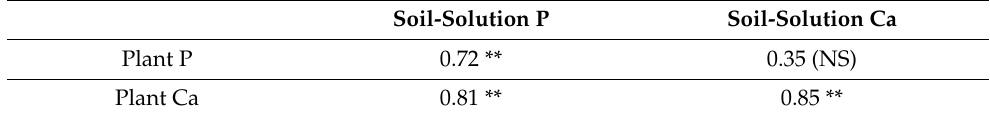
Table 6. Pearson correlation coefficients of plant tissue Ca and P vs. soil-solution Ca and P. Soil-Solution P Soil-Solution Ca Plant P 0.72 ** 0.35 (NS) Plant Ca 0.81 ** 0.85 **